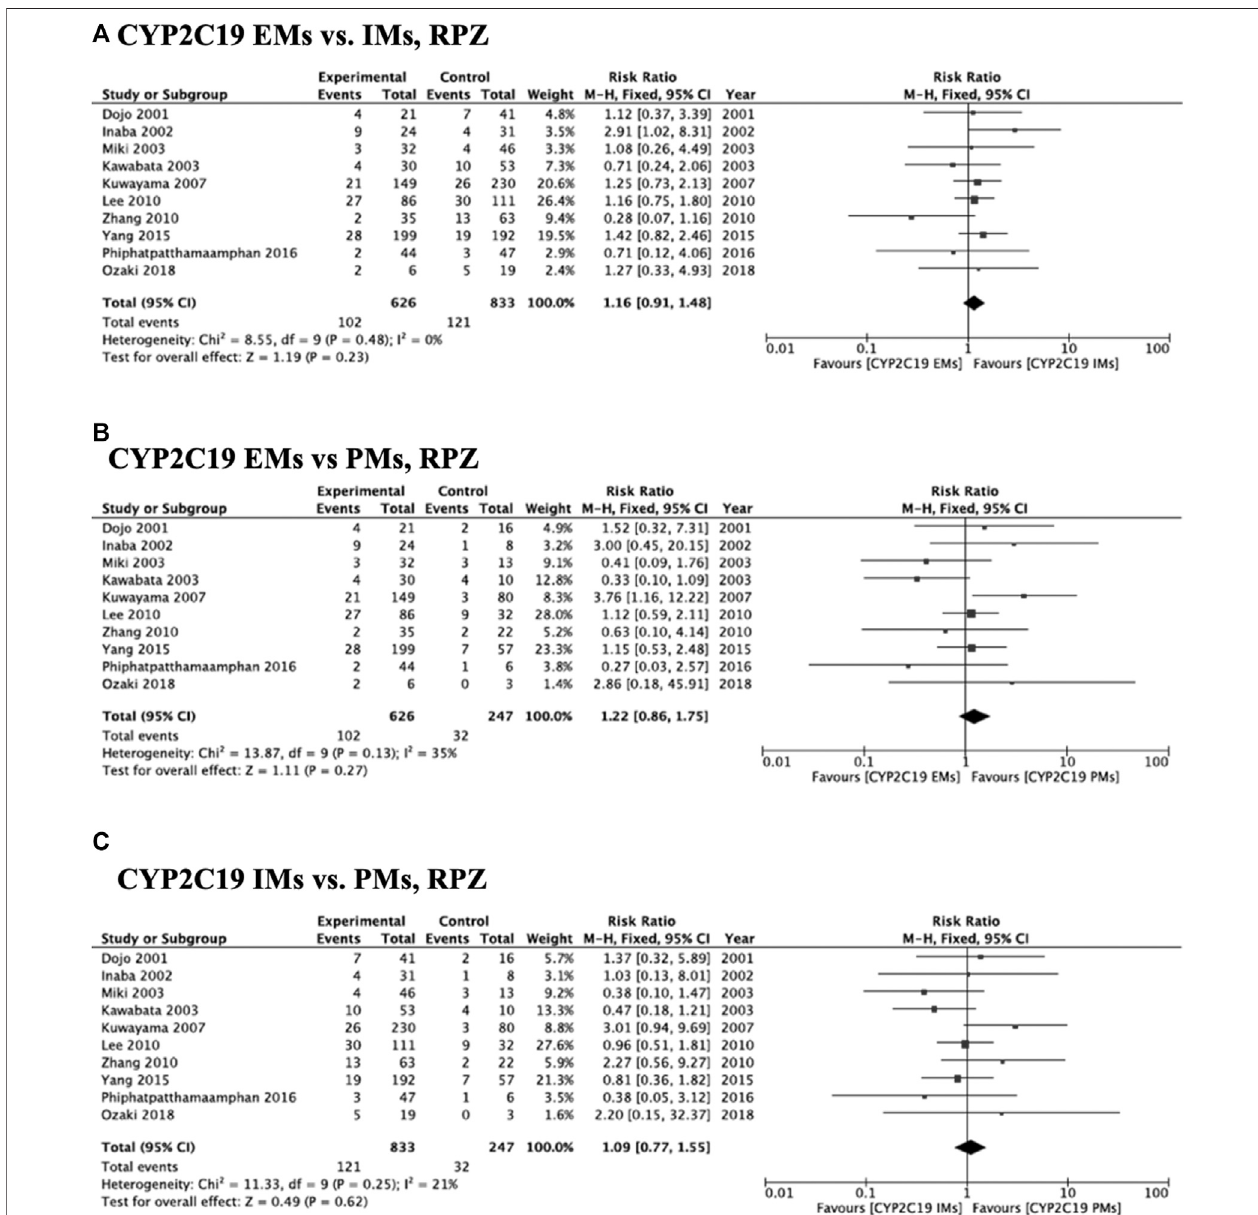
FIGURE 4 | Forest plots of H. pylori cure rates of RPZ-amoxicillin-clarithromycin regimen among different CYP2C19 genotypes in the fi xed-effects model. (A) CYP2C19 EMs vs IMs, (B) EMs vs PMs and (C) IMs and PMs.; Abbreviations: CI, con fi dence interval; EM, extensive metabolizer of CYP2C19; IM, intermediate metabolizer of CYP2C19; PPI, proton pump inhibitor; PM, poor metabolizer of CYP2C19; PPI, proton pump inhibitor; RPZ, rabeprazole.